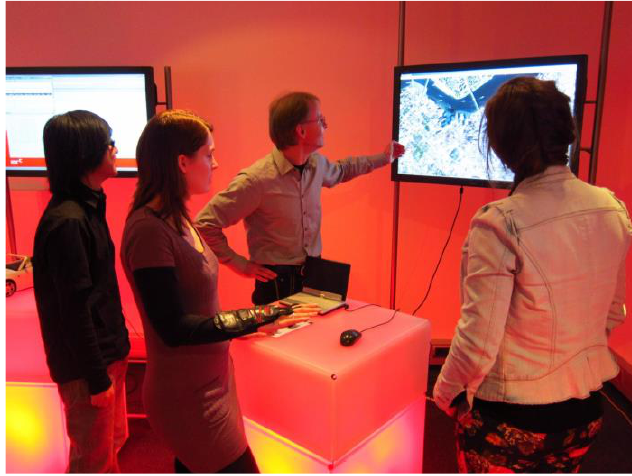
Fig. 1. Science communication needs more tangible forms of stakeholder